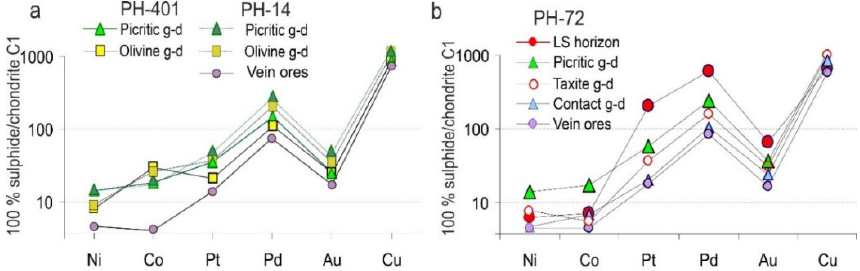
Figure 9. Average compositions of ore elements normalized to chondrite C1 [37]: ( a ) boreholes in which the lower layered series is represented by olivine gabbro-dolerites; ( b ) boreholes in which the lower layered series is represented by taxite gabbro-dolerites.